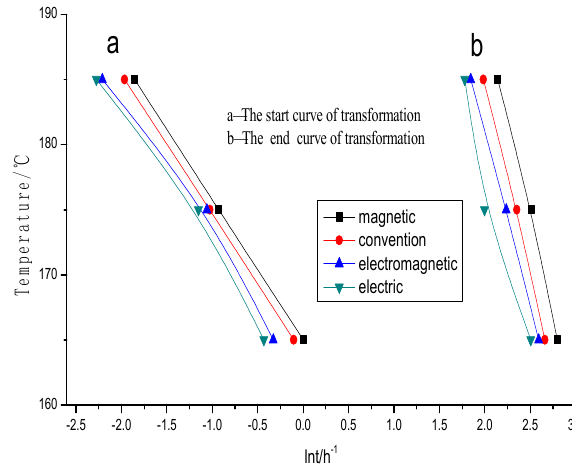
Figure 5. The time ‐ temperature ‐ transformation curves.